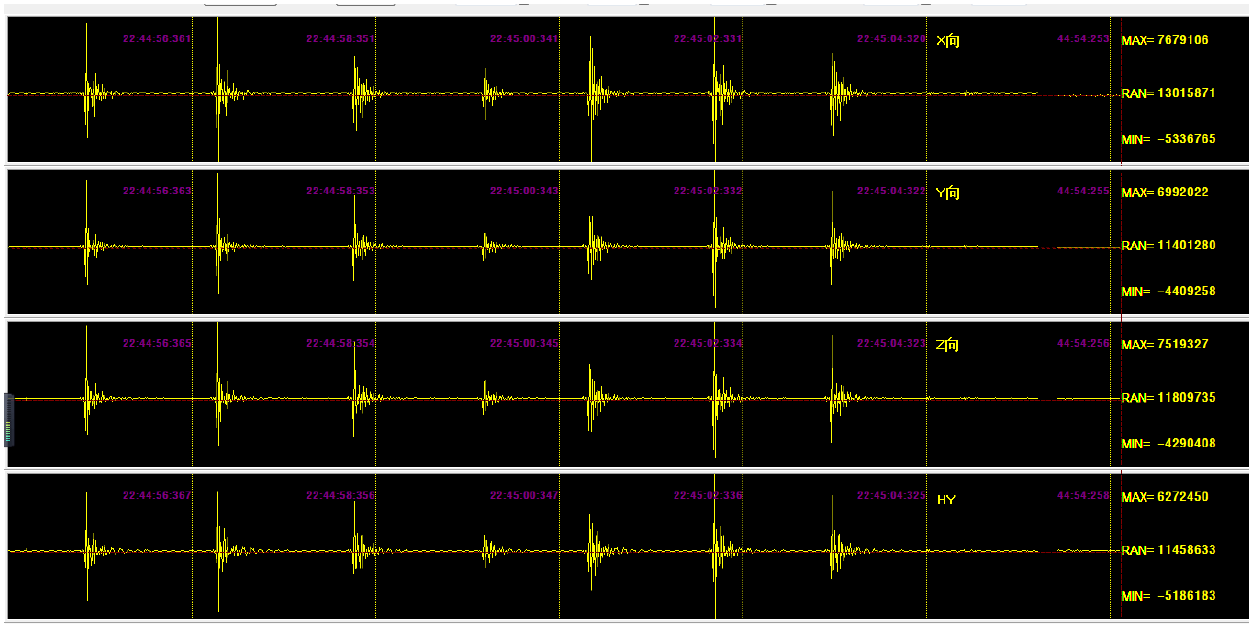
Figure 5. Preliminary laboratory testing of the seismograph for four channels only. The seismic source was banging.